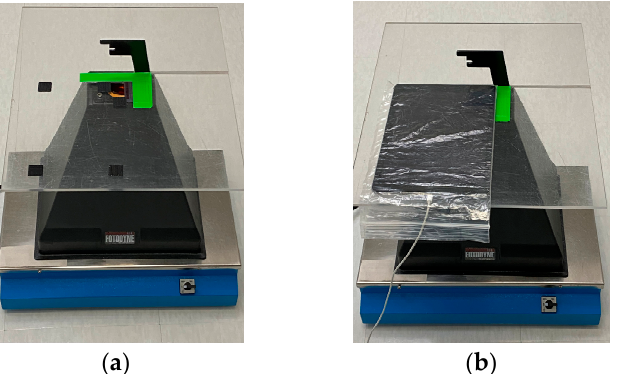
Figure 3. Fully assembled and operational camera mount and hood. A transparent, sealable plastic bag was used as a protective cover for the iPad. First, a ~2 cm square of plastic was removed from one side in the top corner of the bag so that the camera lens would not be covered by the plastic. This cutout faces down on the acrylic sheet, with the iPad resting on top. The iPad is pushed into the top right corner of the bag, with the camera facing down. The best position is determined empirically using an ethidium-stained gel as guide, and the position of the camera is marked on the acrylic. ( a ) When the optimal position is determined, hook-and-loop fasteners with adhesive backing are placed on the back of the plastic bag, the adhesive covering is removed from the other side, and the bag, with iPad, is positioned correctly on the acrylic camera mount, leaving the hook and loop fasteners attached in position. These fasteners are also visible in Figure 2. ( b ) The gel documentation system with discontinued iPad mounted is shown. The bag is sealed around the cord, providing protection from aqueous solutions. Excess bag material can be taped together or sealed with a cooking pouch sealer to minimize movement of the iPad within the bag. This arrangement has proven quite secure. The photography hood can be moved using the camera mount as a handle, and the iPad stays securely mounted on the